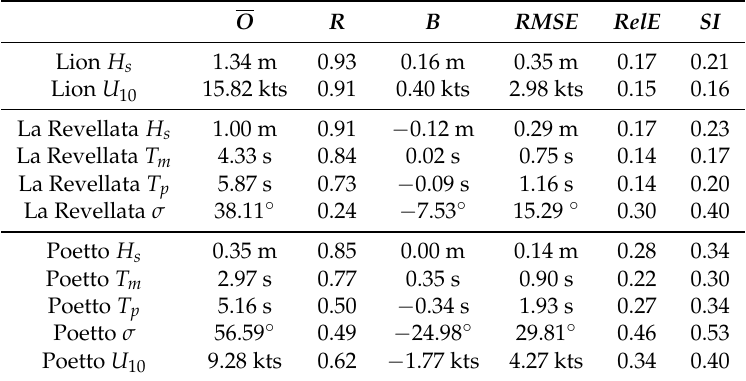
Table 2. Results of statistical analysis of spectral bulk wave parameters and wind speed U 10 at Lion buoy, La Revellata buoy (only wave data) and Poetto